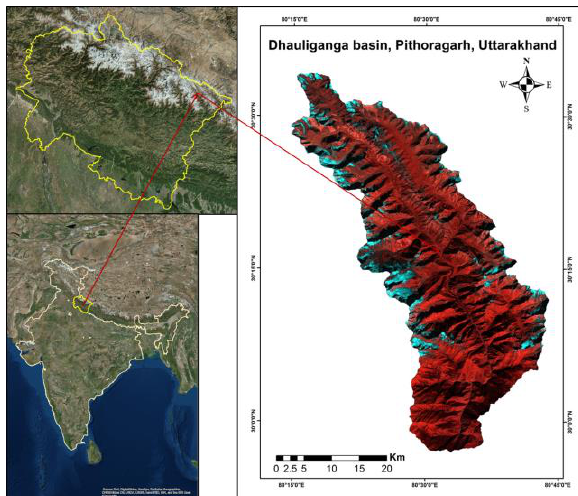
Figure 1. Study Area: Eastern Dhauliganga basin, Pithoragarh district, Kumaun Himalaya, Uttarakhand.